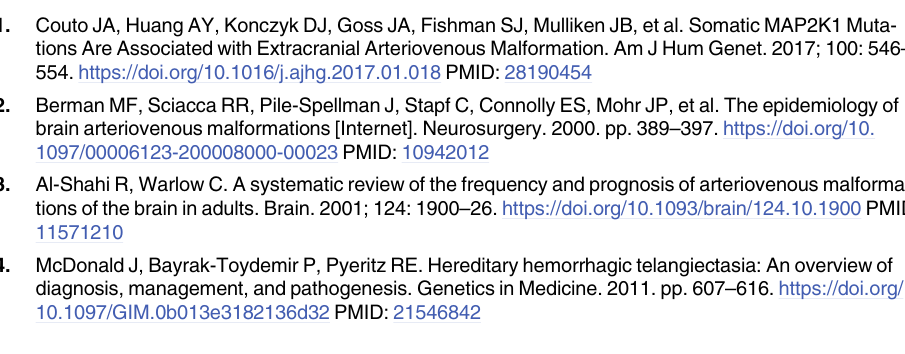
S1 Table. Probe sequences used for gene analysis during molecular inversion probe sequencing. � poorly performing